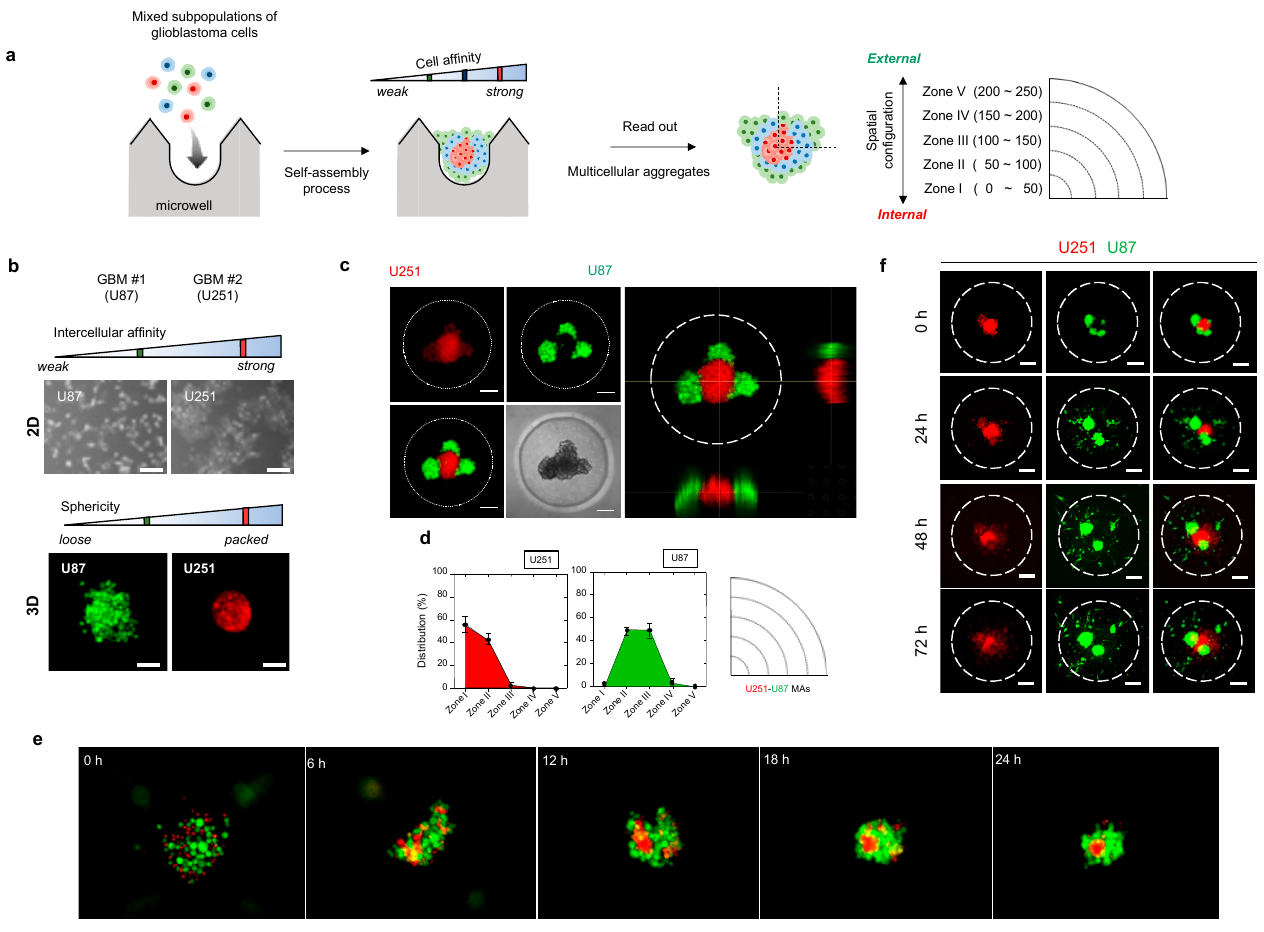
Figure 2. Three-dimensional (3D) heterotypic cultivation for rapid screening of heterogeneous cell populations based on intercellular affinity preferences. ( a ) Schematic overview for assessing the intercellular affinity of patient-derived tumor cells. ( b ) Morphologies of two distinct glioblastoma cell lines in two-dimensional plates and 3D multicellular aggregates. U87MG and U251MG: the two distinct cell lines used in the multicellular aggregation assay system. ( c ) Representative fluorescence images of the 3D spatial distribution of glioblastoma heterotypic multicellular aggregates (MAs). U251 (red), U87 (green). Scale bar: 100 μ m. ( d ) Quantitative analysis of fluorescence images of the 3D spatial configurations and the spatial configurations of MAs based on the evaluation of circular zones. ( e ) Time-lapse photographs of the U251–U87 MA assembly. ( f ) Time-lapse of the invasion of U251–U87 heterotypic MAs over 72 h. Scale bar: 100 μ m.